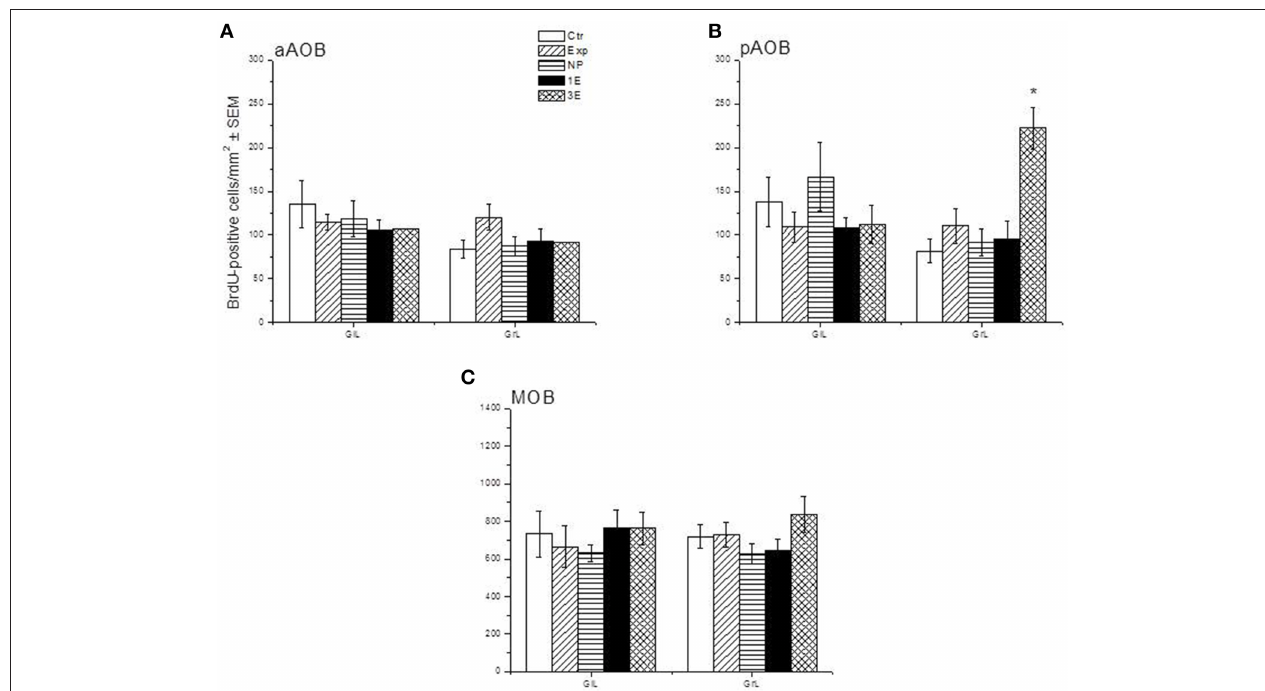
FIGURE 2 | Density of BrdU-positive cells in the sagittal plane in control (Ctr, n = 7 ), exposed (Exp, n = 8 ), non-paced (NP, n = 8 ), 1 ejaculation (1E, n = 6 ) and 3 ejaculation (3E, n = 8 ) groups. The analyzed regions were the GlL and GrL of the aAOB (A) , pAOB (B), and MOB (C) . Data are expressed as the mean ± SEM. * Different from all other groups in the same layer. P < 0.05 .